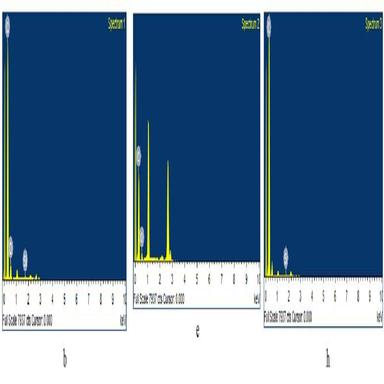
SEM and EDS cross-section images of PC-Ph composite specimen after machining.